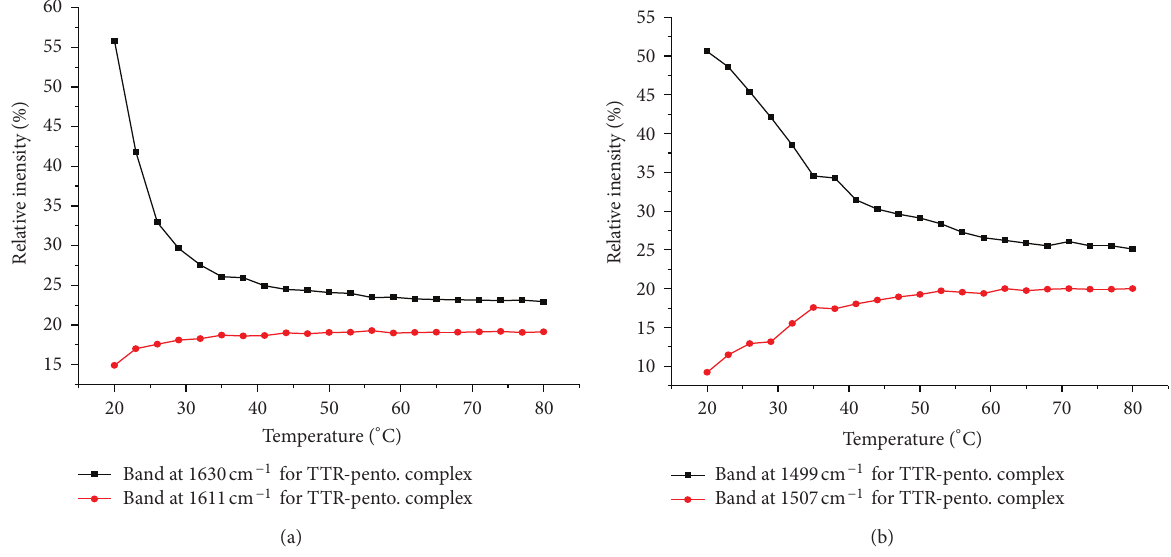
F 8: Relative intensity versus temperature change pentobarbital 1.92mM complexes (a) the bands at 1630cm